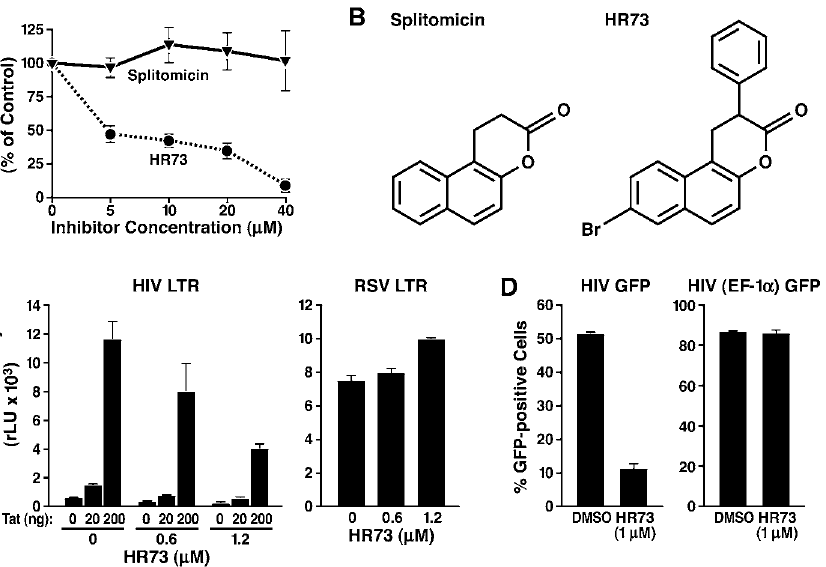
Figure 6. Inhibition of HIV Gene Expression by a Small Molecule Inhibitor of SIRT1 (A) In vitro histone deacetylation assays including recombinant SIRT1, radioactively labeled histone H3 peptide, and indicated concentrations of splitomicin or HR73. The average ( 6 SEM) of two experiments performed in duplicate is shown for each point. (B) Chemical structures of splitomicin and its derivative HR73. (C) Inhibition of Tat transactivation by HR73. RSV-Tat (0, 20, and 200 ng) and HIV LTR luciferase (200 ng) or RSV-luciferase (200 ng) vectors were transfected into HeLa cells. Transfected cells were treated with indicated concentrations of HR73 or DMSO for 8 h. (D) Inhibition of HIV gene expression by HR73. GFP expression in Jurkat T cells infected with HIV NL4–3 containing the GFP open reading frame in place of the viral nef gene or with an HIV-based lentiviral vector expressing GFP from the heterologous EF-1 a promoter. Treatment with HR73 (1 l M in DMSO) or DMSO was performed for 36 h after overnight infection. The average ( 6 SEM) of four experiments is